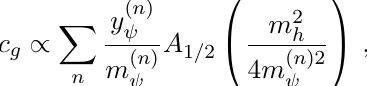
p 1 (cid:0) (cid:24) and 1 (cid:0) 2 (cid:24)